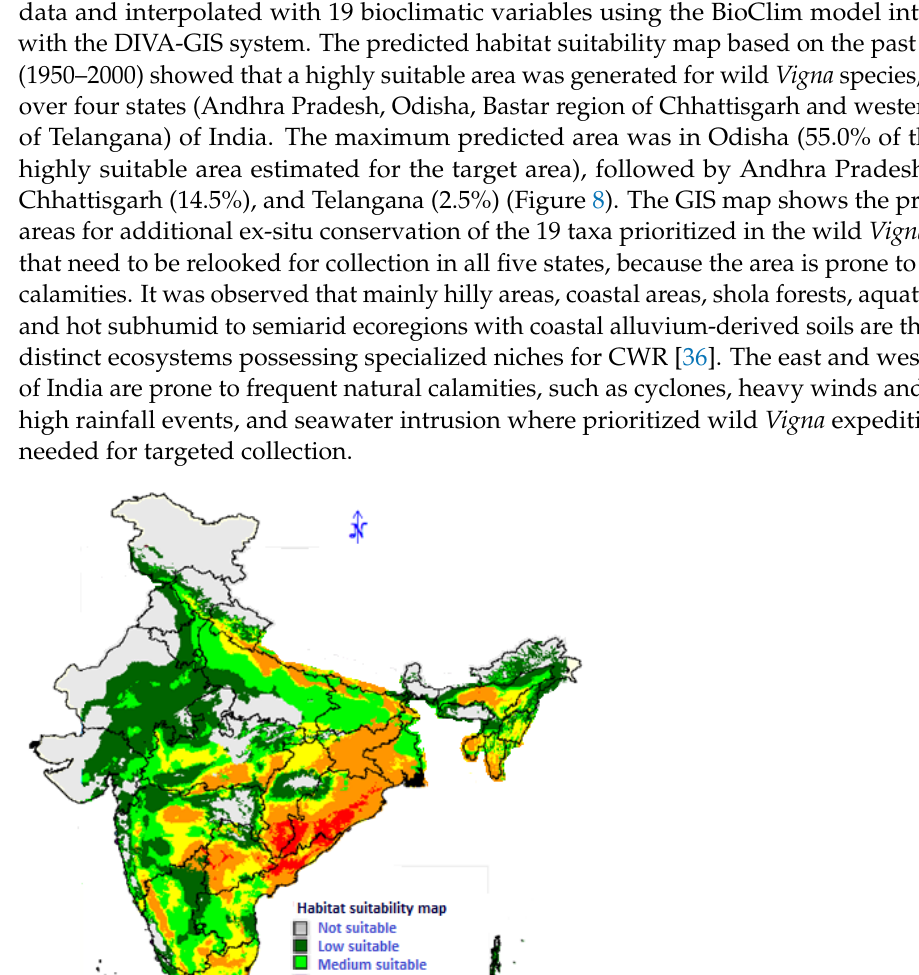
wild Vigna species across the country are given in Table 1. Table 1. Collection gaps and areas identi fi ed for the survey, exploration, and expedition of wild Vigna species based on collected and conserved germplasm data. Wild Vigna Areas identified Based on Gaps in Collections Germplasm collected but less conserved V. bourneae (Gamble) Tateishi & Maxted